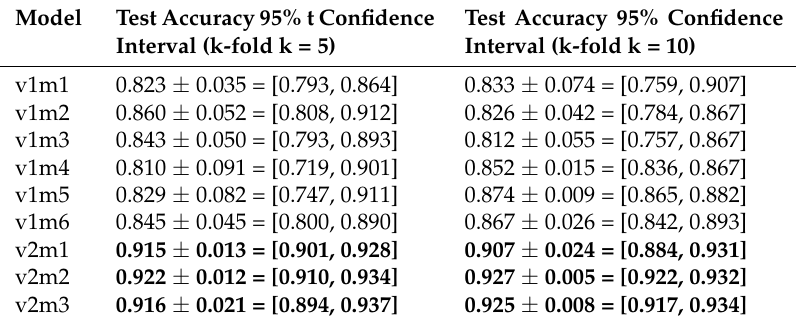
Table 3. Test accuracy (95% confidence intervals) for all models calculated from k-fold results for the IGN-PNOA dataset. For each model and k value, we show the calculated accuracy, expected interval mean, standard deviation and the interval itself.